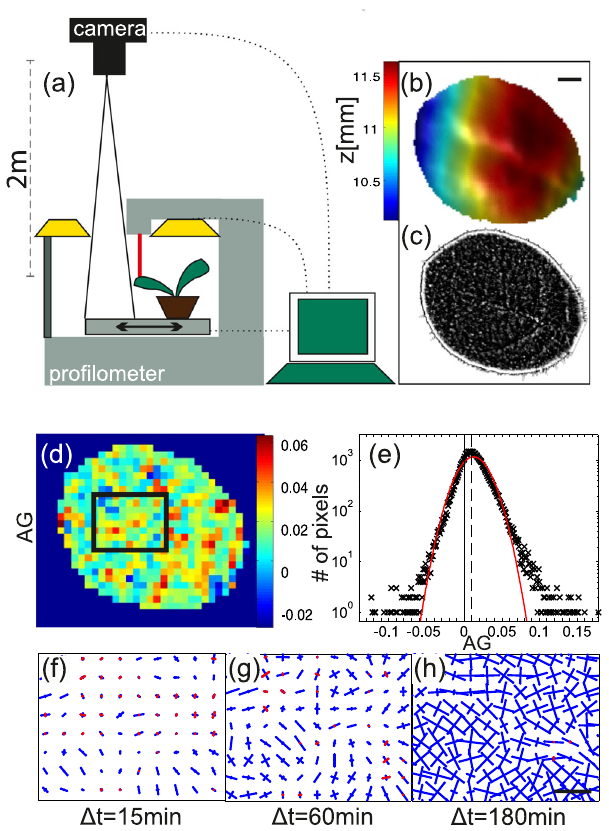
Fig. 1 The leaf growth measuring system and example dynamics of local growth. a A pot with a living plant is placed on the x – y stage of a pro fi lometer. The stage and the lighting conditioned are controlled by a preset program, by which the leaf is automatically scanned (red line marks scanning beam) and then optically imaged, in constant time intervals for days. The camera is set at 200 cm distance from the leaf plane, in order to minimize optical artifacts due to vertical growth (Supplementary Note 1). b A typical leaf topography z ( x , y ) of a Tobacco wild-type leaf (after smoothing) as obtained by the pro fi lometer. Scale bar: 1 mm. c An optical image of the leaf in b , after deleting the low spatial frequency data (black). the small-scale features (white) are used as tracers in the growth calculation algorithm. d An example of an area-growth fi eld, ( AG ), measured within the time interval Δ t ¼ 15min. Spatial resolution: 250 × 250 micron. e A histogram of all area-growth values, during 90 intervals of Δ t ¼ 15min during 2 days of measurement ( ∼ 70,000 growth events). The most probable value is ∼ 1% (dashed line). A Gaussian distribution with the same mean and std is depicted in a solid red line. f – h Principal growth measurements, taken from the same leaf area (marked with a rectangle in d ) with different time intervals (indicated, all during light-time). At each point, the maximal and minimal growth vectors are depicted: The lines are oriented along the principal directions and their lengths indicate the relevant growth values (scaled by the same arbitrary factor in all panels). Blue lines represent positive growth, red lines represent shrinkage. Scale bar: 0.5 mm. More samples of such data, in Supplementary Fig. interval (i.e., its surface area increased) many spots shrank (blue areas in Fig. 1d). Plotting the histogram of the local surface growth during 90 intervals of 15 min each (Fig. 1e) shows a signi fi cant part of the distribution consists of negative values of AG . The histogram is broad — its std is much larger than its mean. It is non-Gaussian (i.e., not a distribution of a random, non- correlated variable), as it has long tails that are slightly skewed.